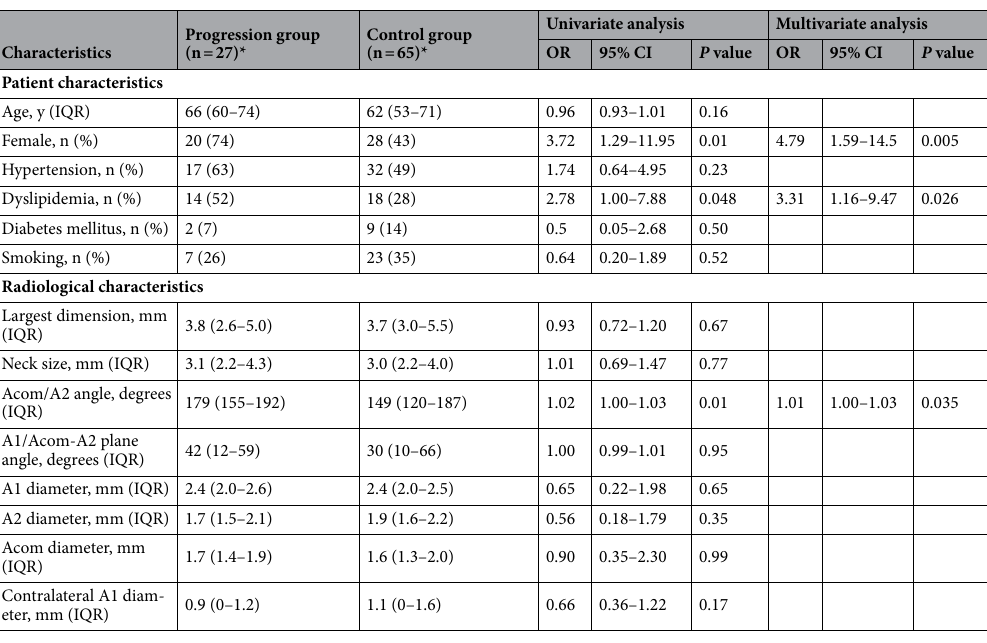
Table 1. Baseline patient and radiological characteristics of anterior communicating artery aneurysms with (n = 27) or without (n = 65) progression. *Data are shown as n (%) or median (IQR) values. Statistical analyses included in this table were performed using EZR version 1.54 23 . CI confidence interval, IQR interquartile range, OR odds ratio.